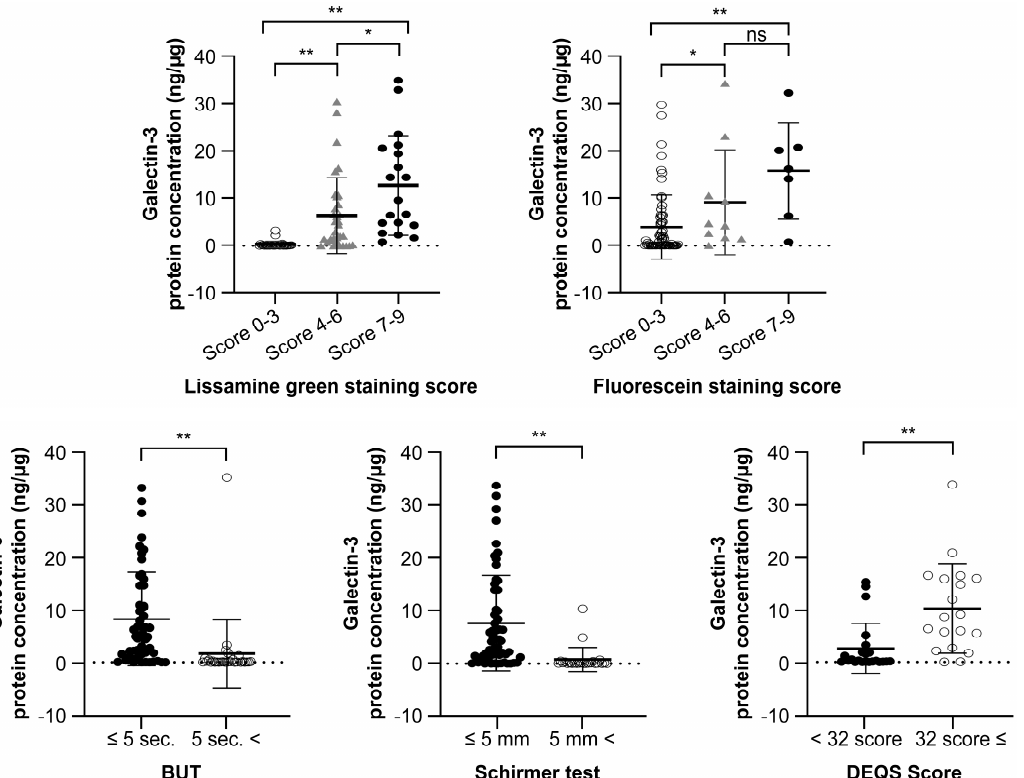
Figure 2. Based on the LG score, there were significant difference between the 7–9 and 0–3 ( p < 0.01), 7–9 and 4–6 ( p < 0.05), and 4–6 and 0–3-point groups ( p < 0.01). FL score was also significantly different between the 7–9 and 0–3 ( p < 0.01), 7–9 and 4–6 ( p < 0.05), and 4–6 and 0–3-point groups ( p < 0.01). Similarly, TBUT, Schirmer’s value, and DEQS were different between the two groups (TBUT ≤ 5 and >5 s, p < 0.01; Schirmer’s test ≤ 5 and >5 mm, p < 0.01; DEQS score < 32 and ≥ 32, p < 0.01. ** p < 0.01; * p < 0.05; n.s., not significant. LG, lissamine green staining; FL, fluorescein staining; DEQS, dry eye questionnaire score; TBUT, tear film break-up